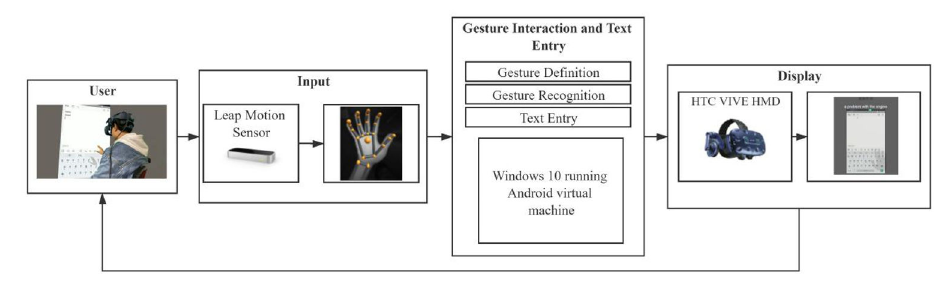
Figure 1. The technical architectural diagram of the gesture-based mid-air text entry technology.